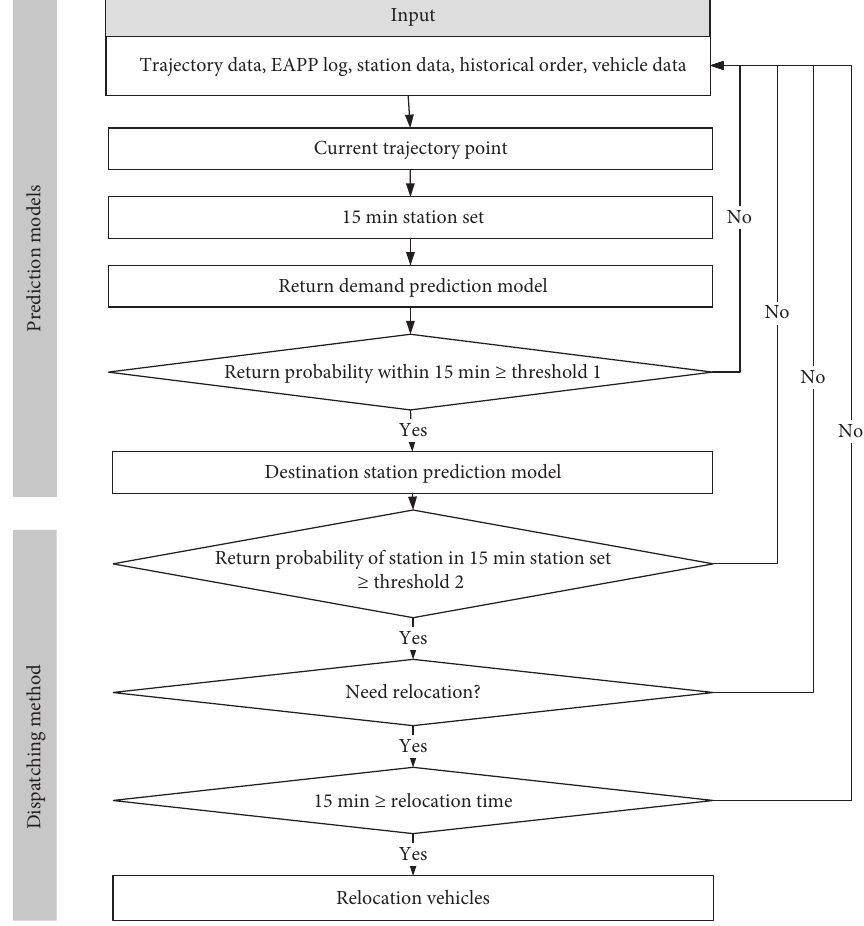
Figure 2: Framework of the study.